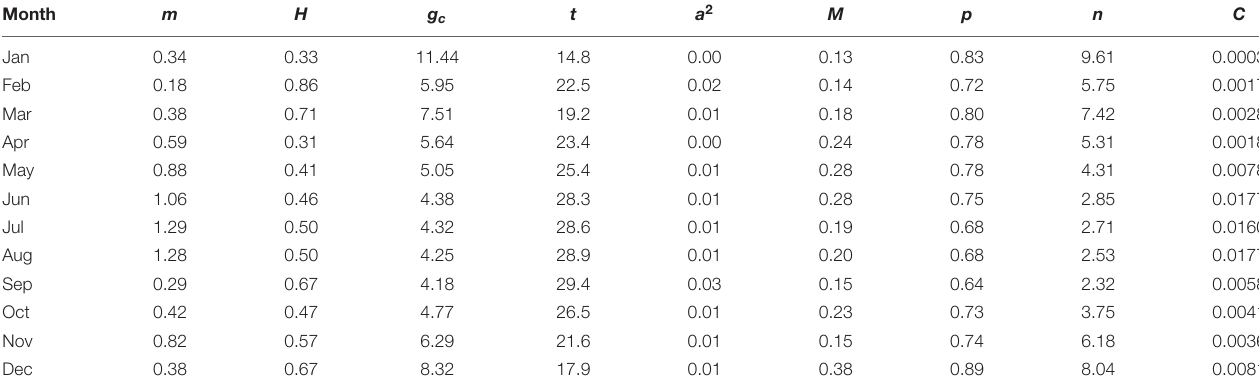
TABLE 3 | Vectorial capacity components of Cs. melanura for EEEV. Mosquitoes were collected in Orange and Polk County, FL, in 2018.